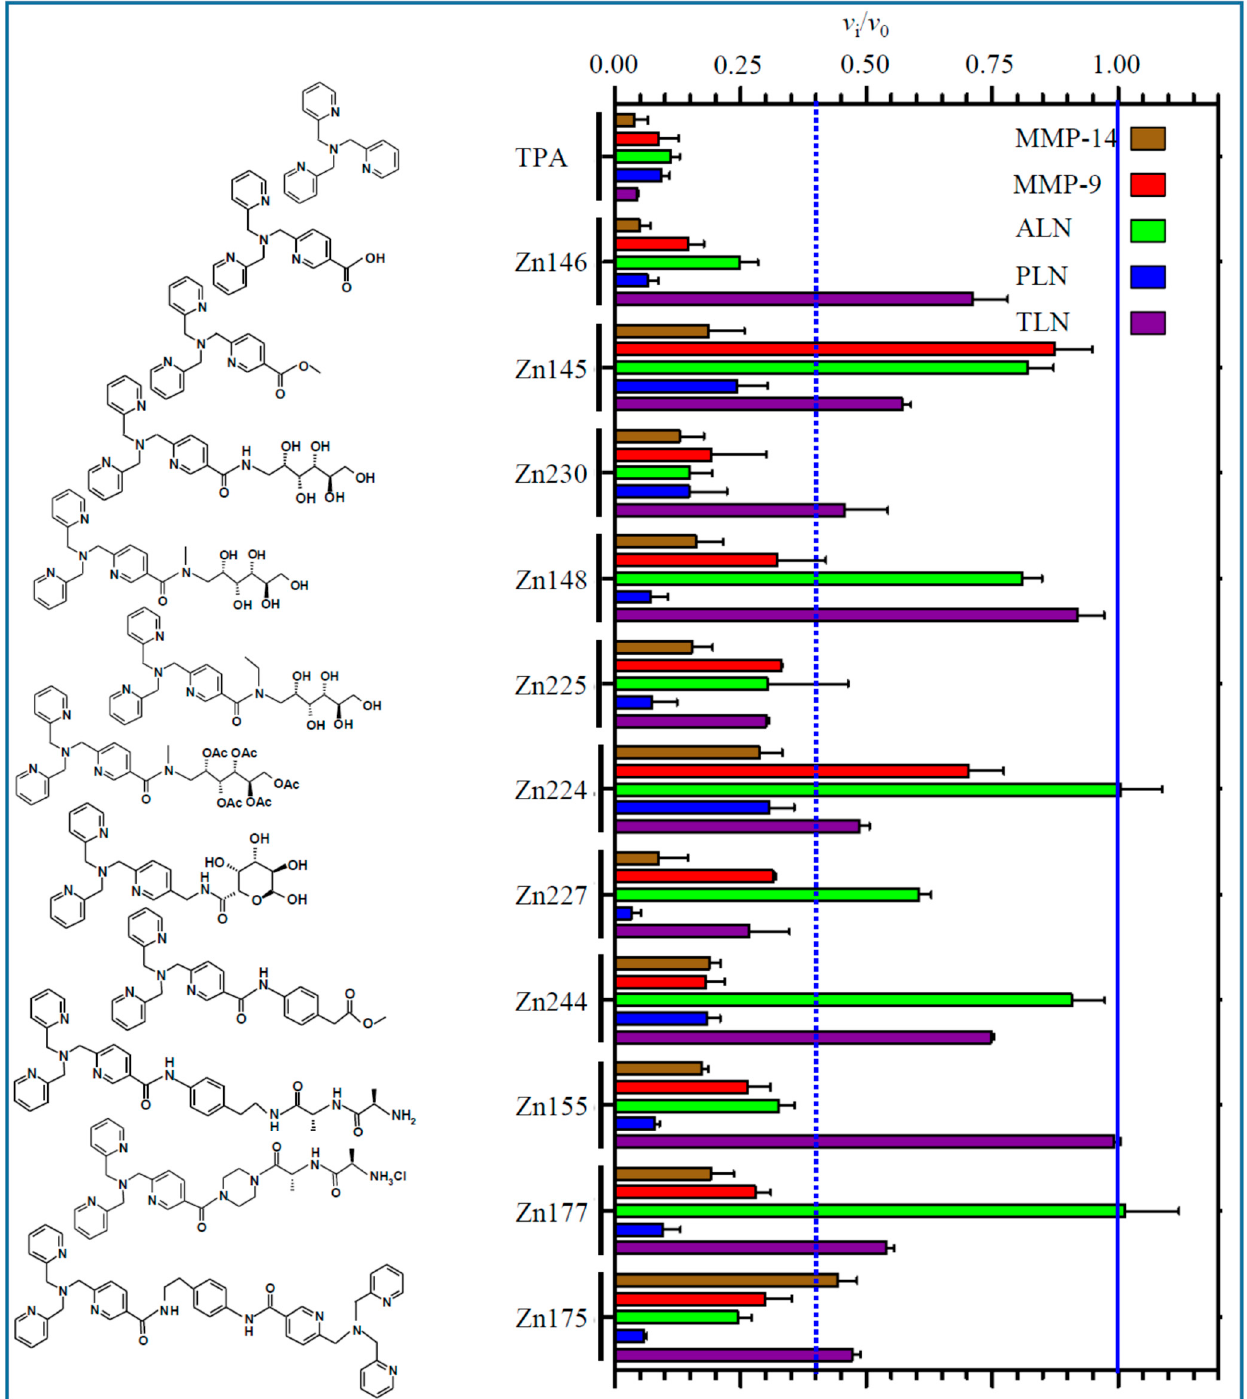
Figure 2. Inhibitory effect of 100 μ M of TPA derivatives on the activity of MMP-9, MMP-14, TLN, PLN and ALN . For compounds with fast inhibitory binding, the v i / v 0 (mean ± s.e.m.) was based on the mean values after 0–45 or 0–30 min pre-incubation. For compounds with time-dependent slow inhibition the v i / v 0 (mean ± s.e.m.) was based on pre-incubation time points where the time curve in supplementary material Figure S1 flattens out. For compounds where the time curve was not flattening out after 45 min of pre-incubation (not reached equilibrium), the mean value was for 30 and 45 min pre-incubation.